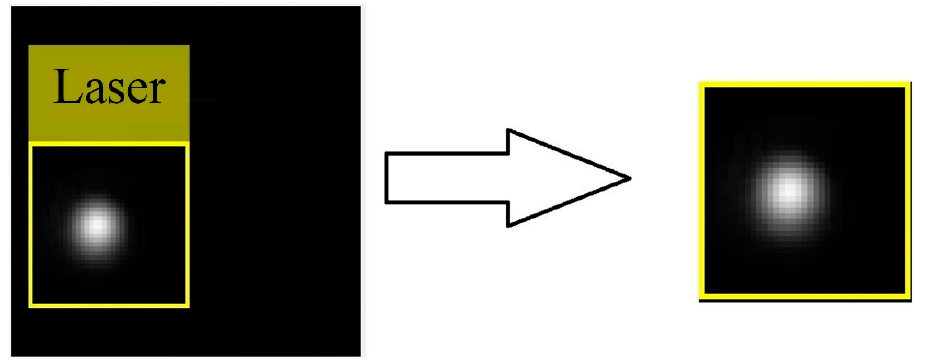
Figure 6. Positioning region template.